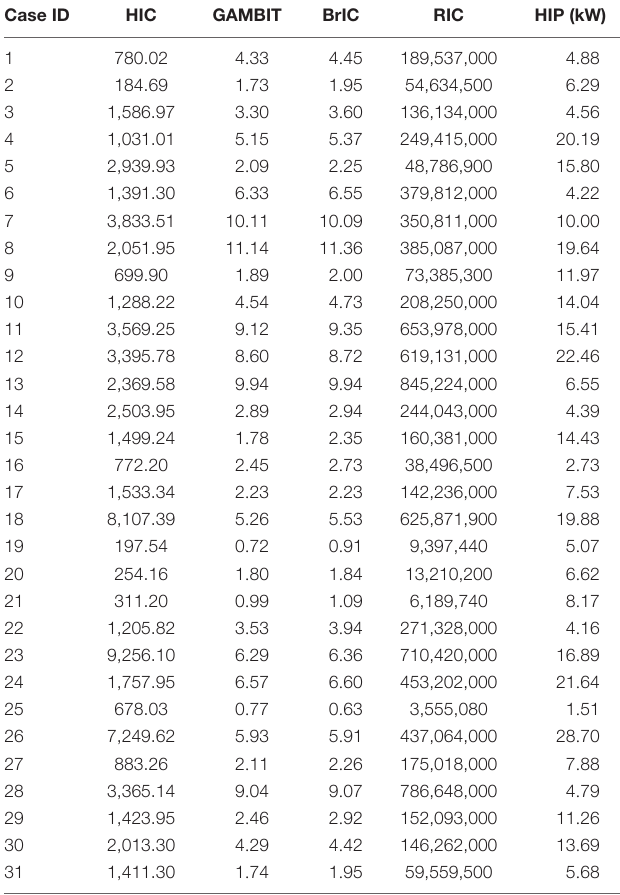
TABLE 4 | Calculated parametric values of head injury criteria.